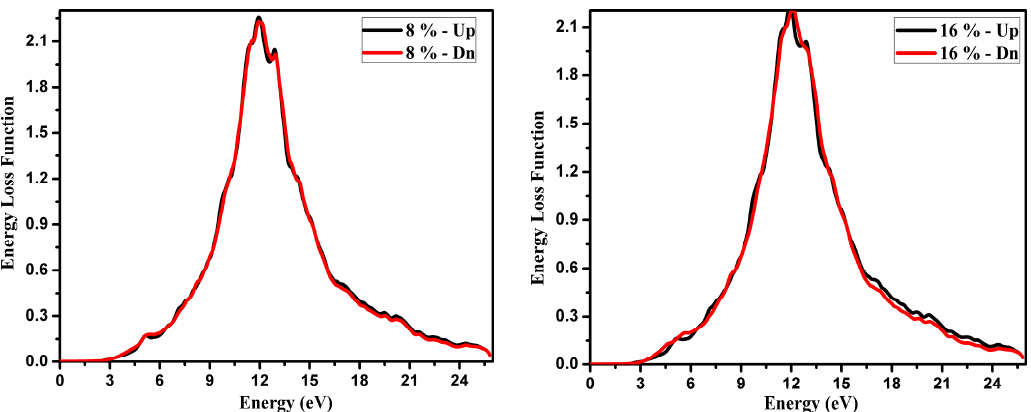
Figure 9. Calculated reflectivity (long solid curve ‐ black color for up) and (long solid curve ‐ red color for down) spectra of Mn x Zn 1 − x Te (x = 8% and 16%).